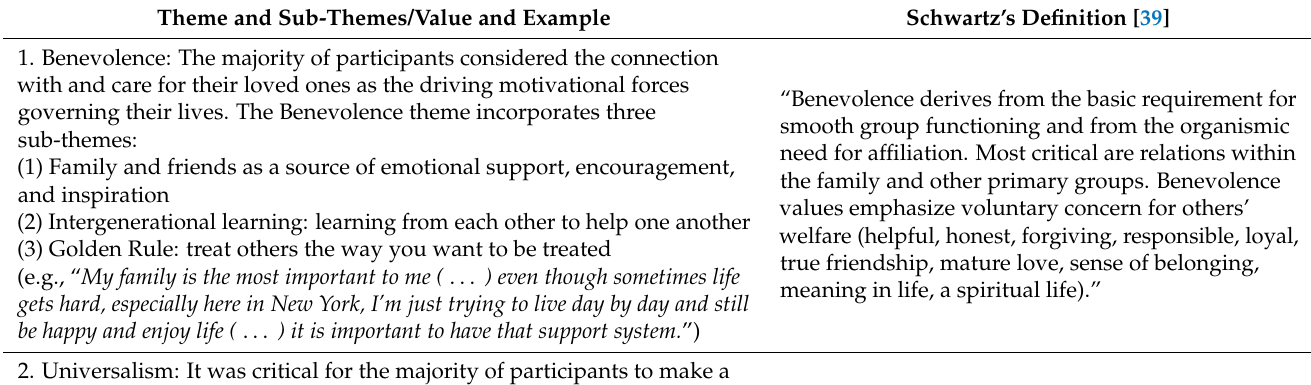
Table 1. Values derived from the qualitative interviews. Examples and